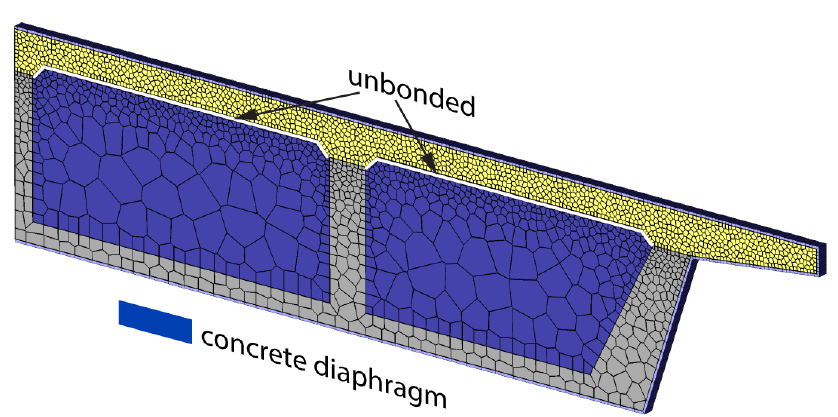
Figure 24. Discretization of box girder cross-section including cell